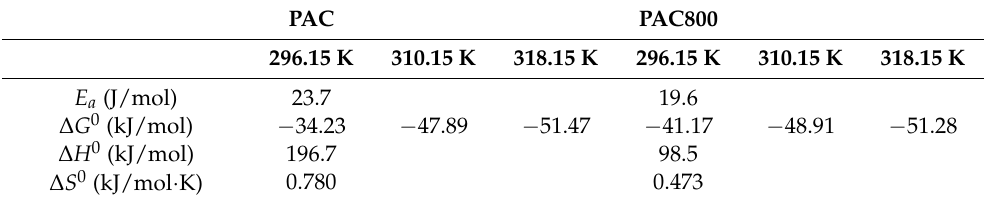
Table 5. Thermodynamic parameters of TC adsorption by PAC and